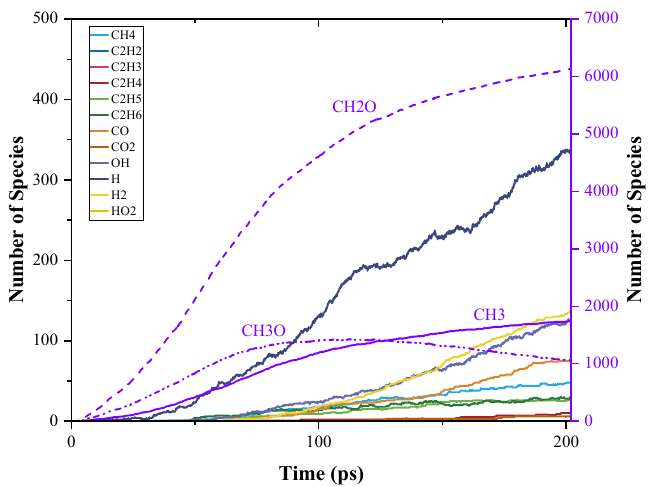
Figure 8. Time evolution of C0-C2 species during the simulation of PODE3 pyrolysis using ReaxFF MD.